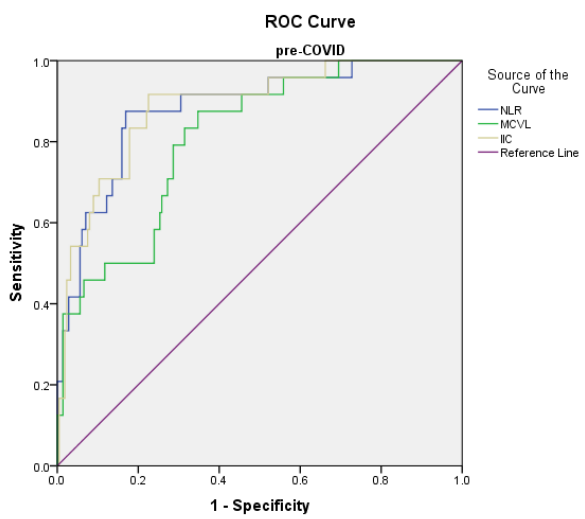
Figure 4. Receiver operating characteristic (ROC) curve for logistic regression models of inflammatory markers related to death in the pre-COVID group. Table 7. Cutoff values of laboratory parameters for determining the risk of complications with surgical risk in the pre-COVID (1) and peri-COVID (2) groups.